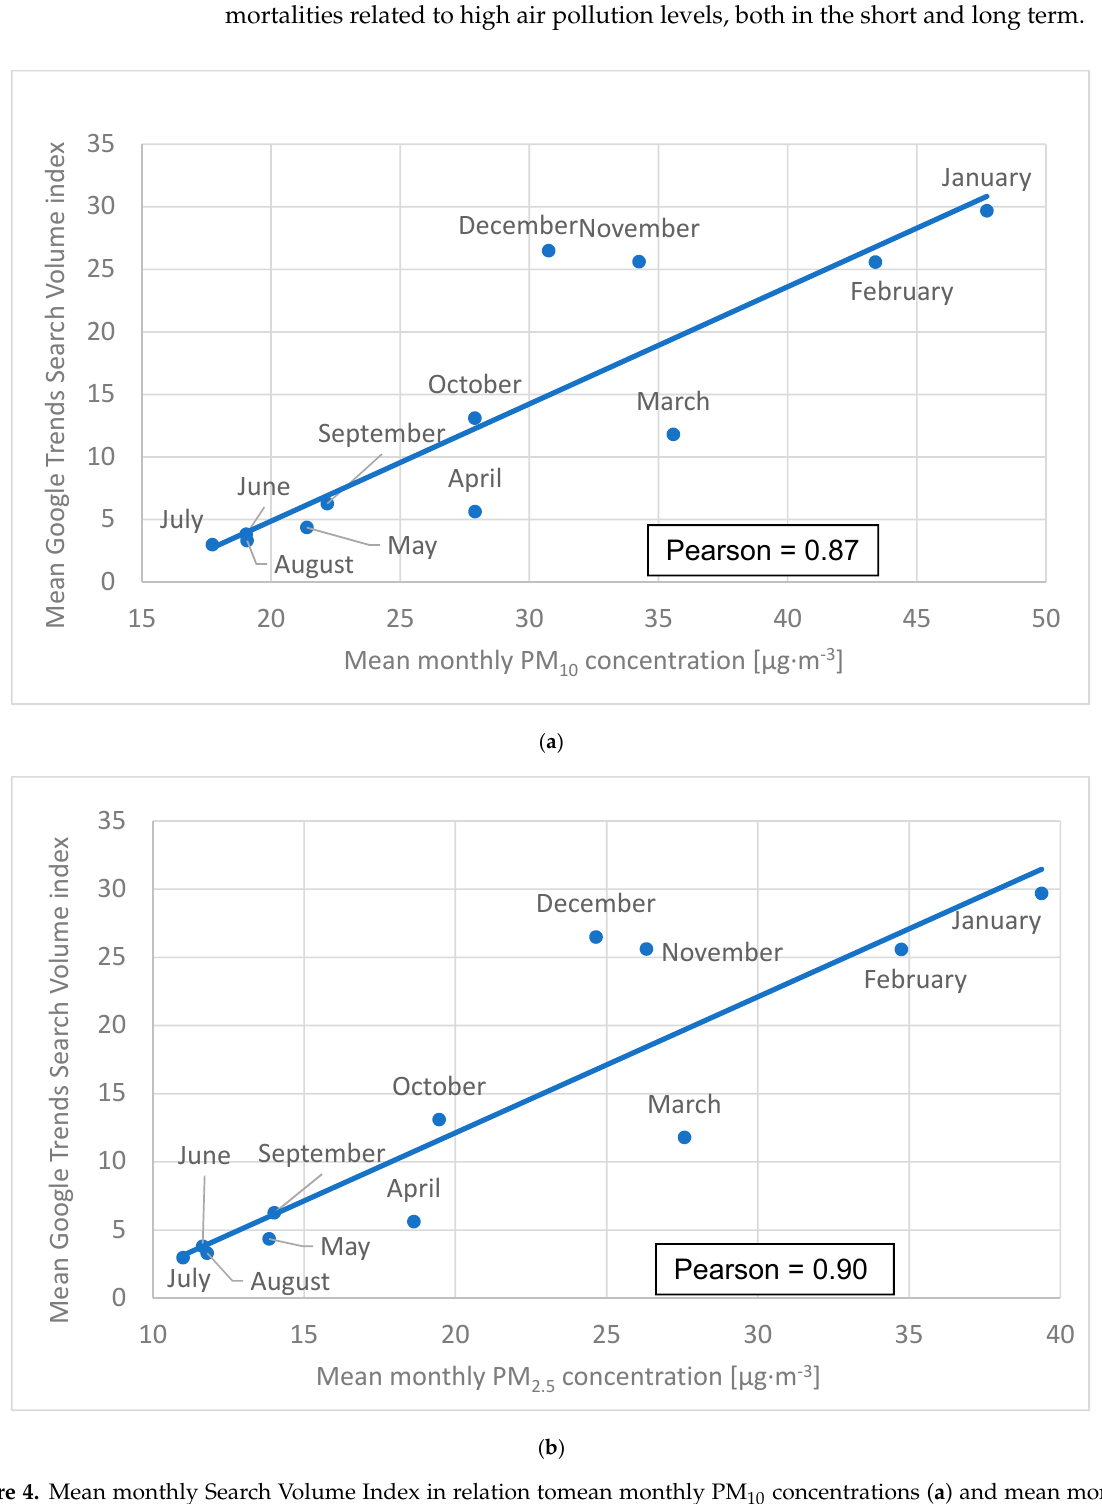
Figure 4. Mean monthly Search Volume Index in relation tomean monthly PM 10 concentrations ( a ) and mean monthly PM 2.5 concentrations ( b ).